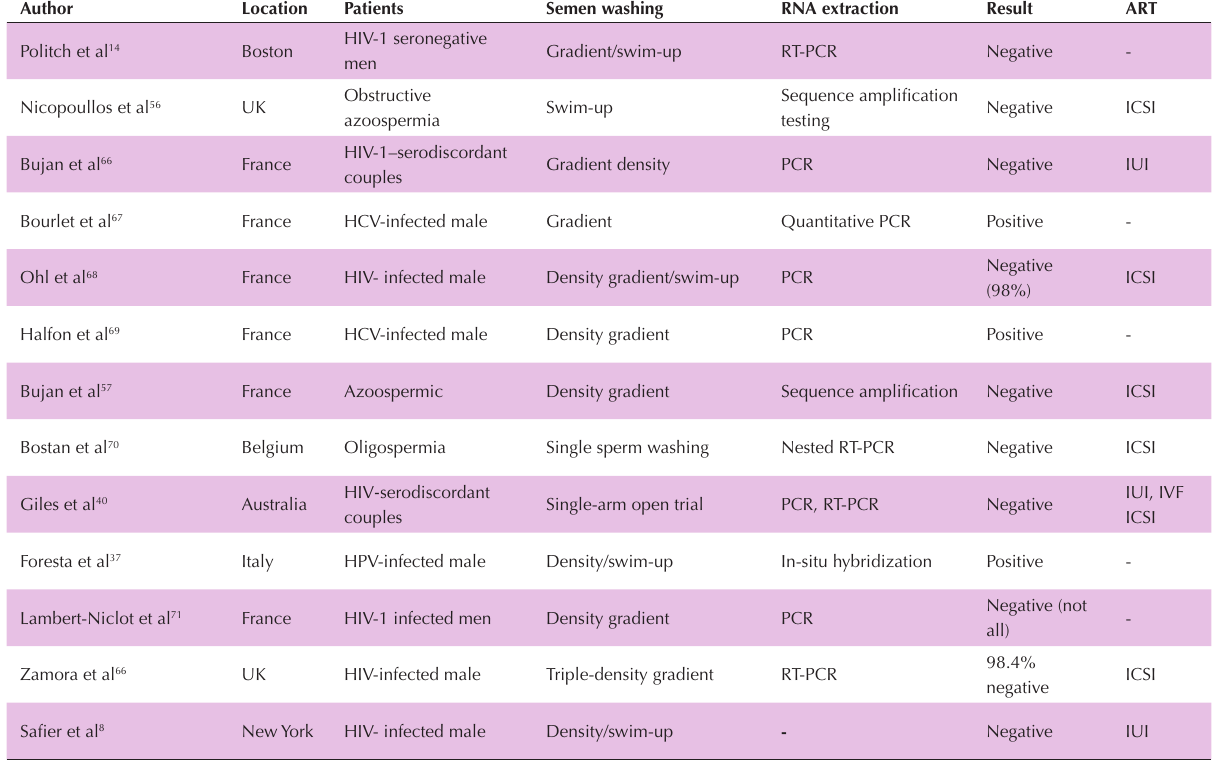
Table 1. List of studies conducted in the field of semen